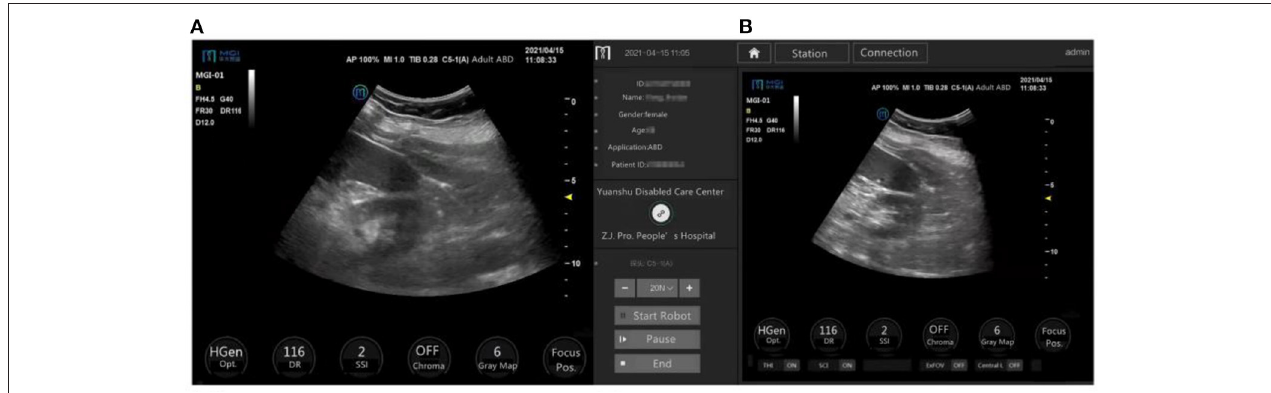
FIGURE 5 | Ultrasound images on the patient side (original images) and doctor side (transmitted images) of the same organs in the same patient. The ultrasound image of the left kidney and the inferior pole of the spleen, displayed on the patient-side, scored 4.3 points on average (A) , and on the doctor side scored 4.7 points on average (B) according to three independent